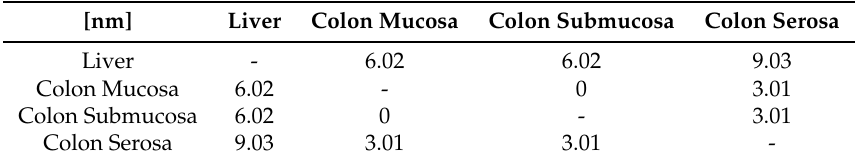
Table 3. Variation (sensibility) of the peak wavelength.